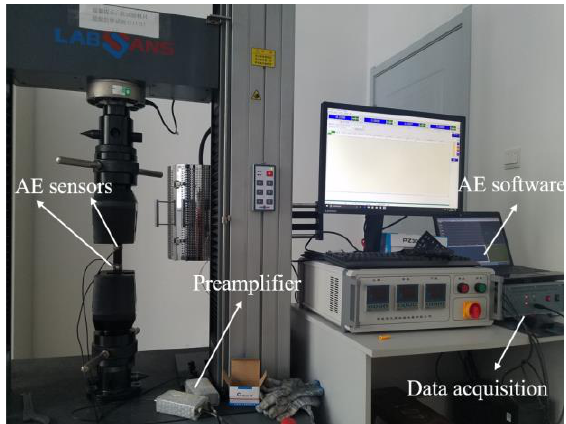
Figure 2. Experimental system of tensile tests and acoustic emission (AE)